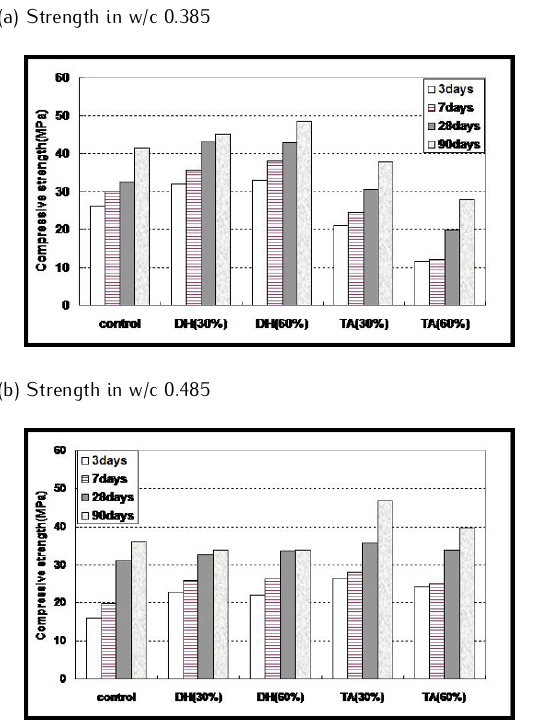
Figure 8. Compressive strength with different mix conditions (with